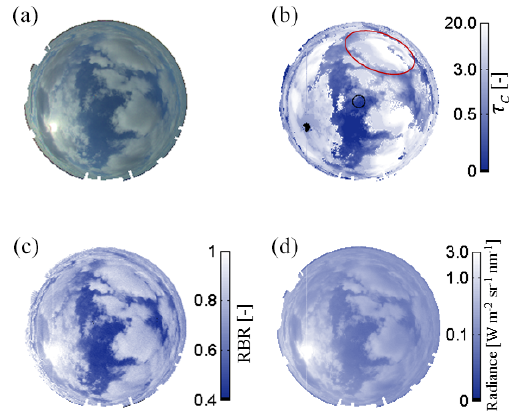
Figure 9. Flowchart of the radiance red–blue ratio (RRBR) method for τ c estimation. If I meas τ c is assigned not-a-number.